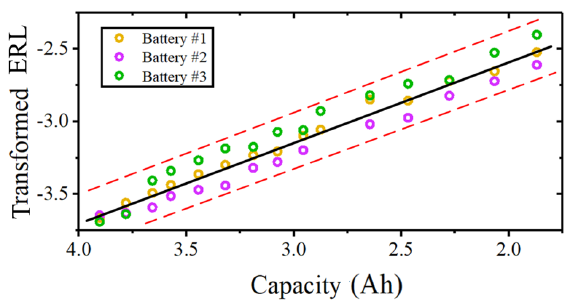
Figure 5. Log-likelihood function with parameter λ .